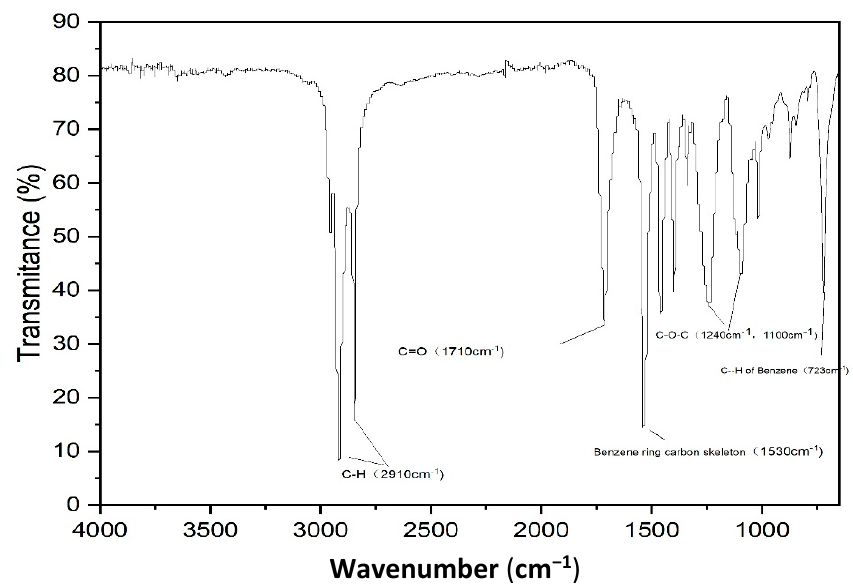
Figure 3. The characteristic FT − IR spectra of the raw PET.